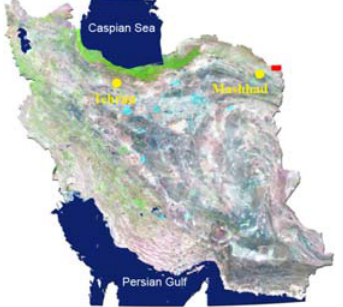
Figure 1. Location of the study area in Iran